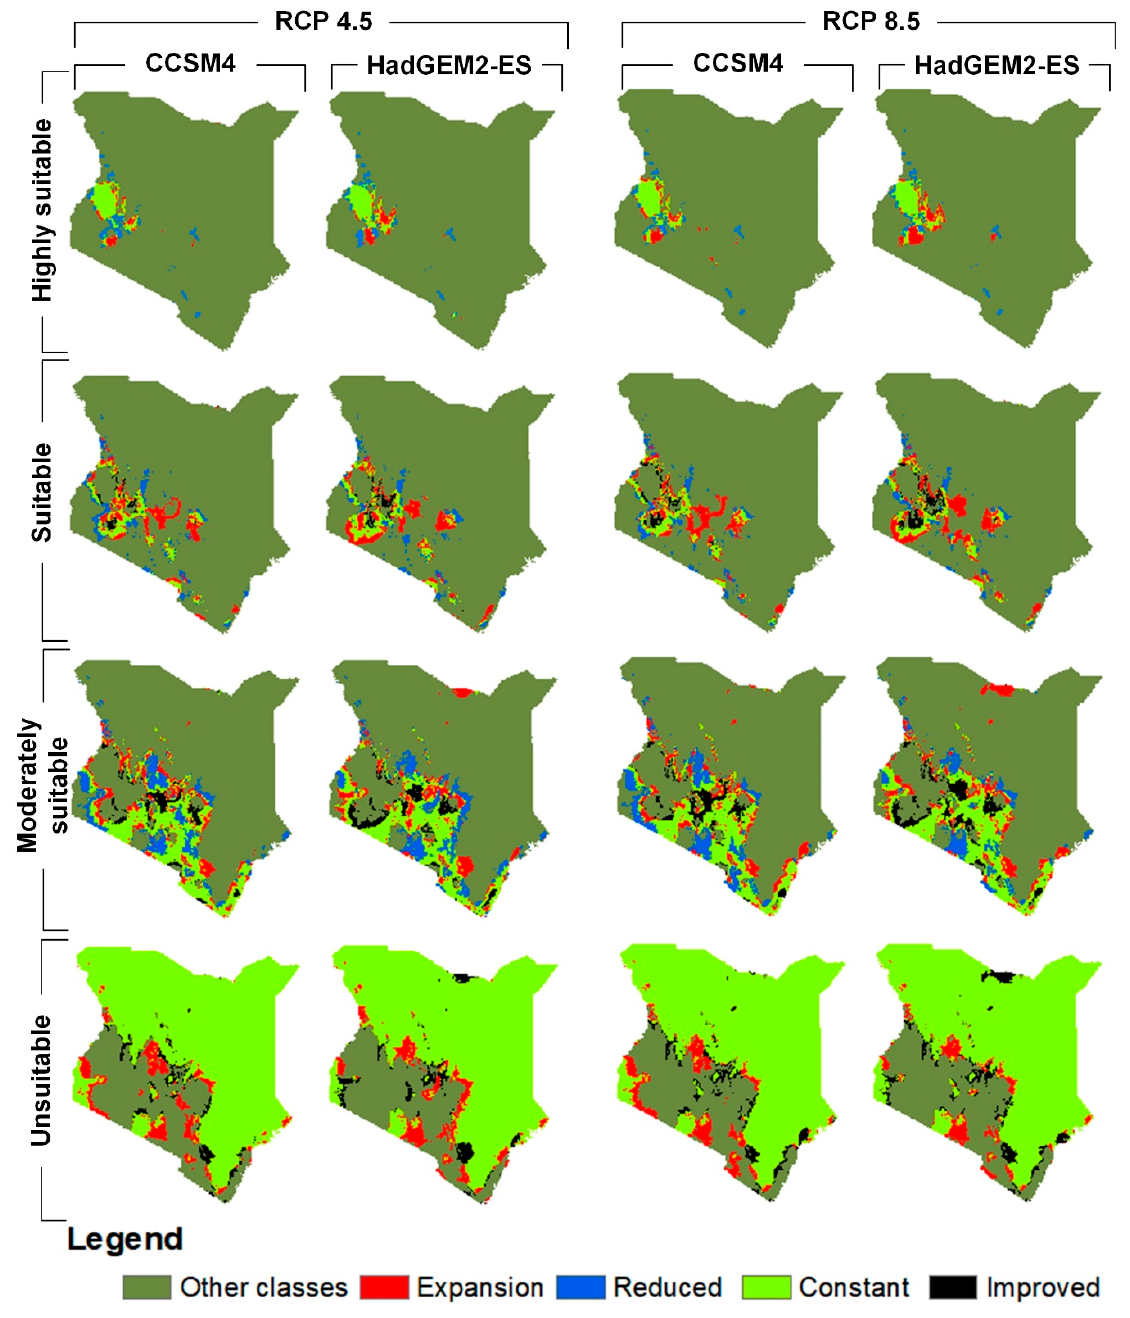
Figure 8. Changes in suitability zones across the country for maize production by Figure 8 . Changes in suitability zones across the country for maize production by 2070.